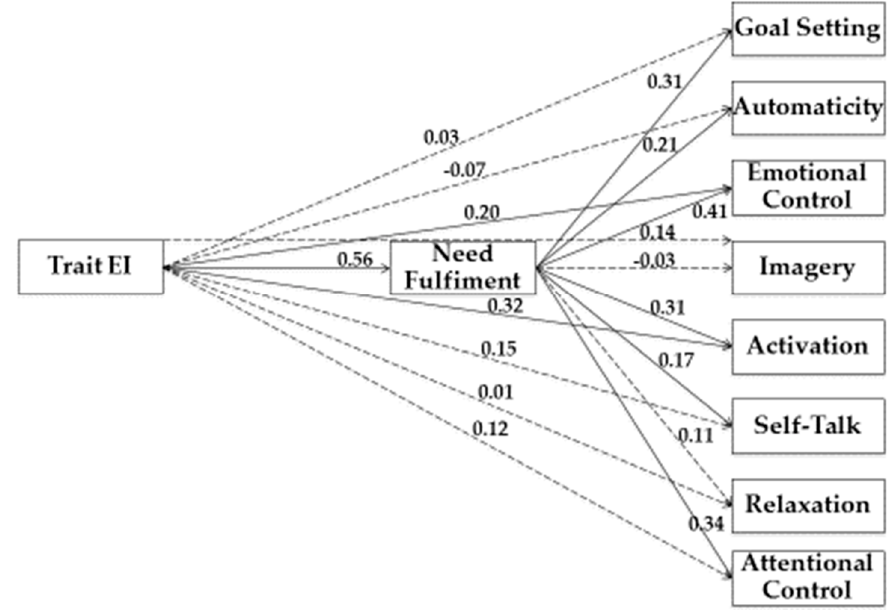
Figure 3. Structural model of associations between Trait EI, Need Fulfiment, and training strategies. strategies. Note: Coe ffi cients shown are standardized path coe ffi cients. Dotted lines represent Note: Coefficients shown are standardized path coefficients. Dotted lines represent non-significant non-significant relations.